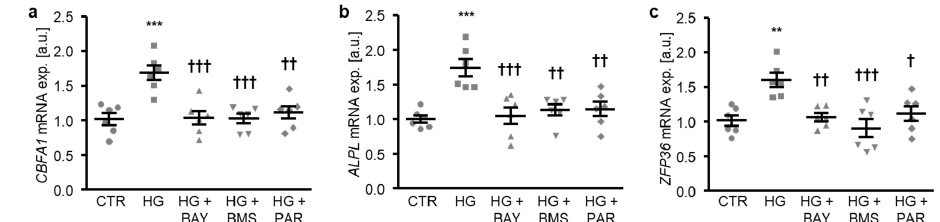
Figure 5. NF- κ B inhibition reduces high glucose-induced osteogenic signaling in HAoSMCs. ( a – c ) Scatter dot plots and arithmetic means ± SEM ( n = 6; arbitrary units, a.u.) of the CBFA1 ( a ), ALPL ( b ), and ZFP36 ( c ) relative mRNA expression in HAoSMCs following treatment with control (CTR) or 50 mM of glucose (HG) without or with 10 µ M of BAY11-7082 (BAY), 10 µ M of BMS-345541 (BMS), or 10 µ M of parthenolide (PAR). ** p < 0.01, *** p < 0.001 significant vs. control HAoSMCs; † p < 0.05, †† p < 0.01, ††† p < 0.001 significant vs. HG-treated